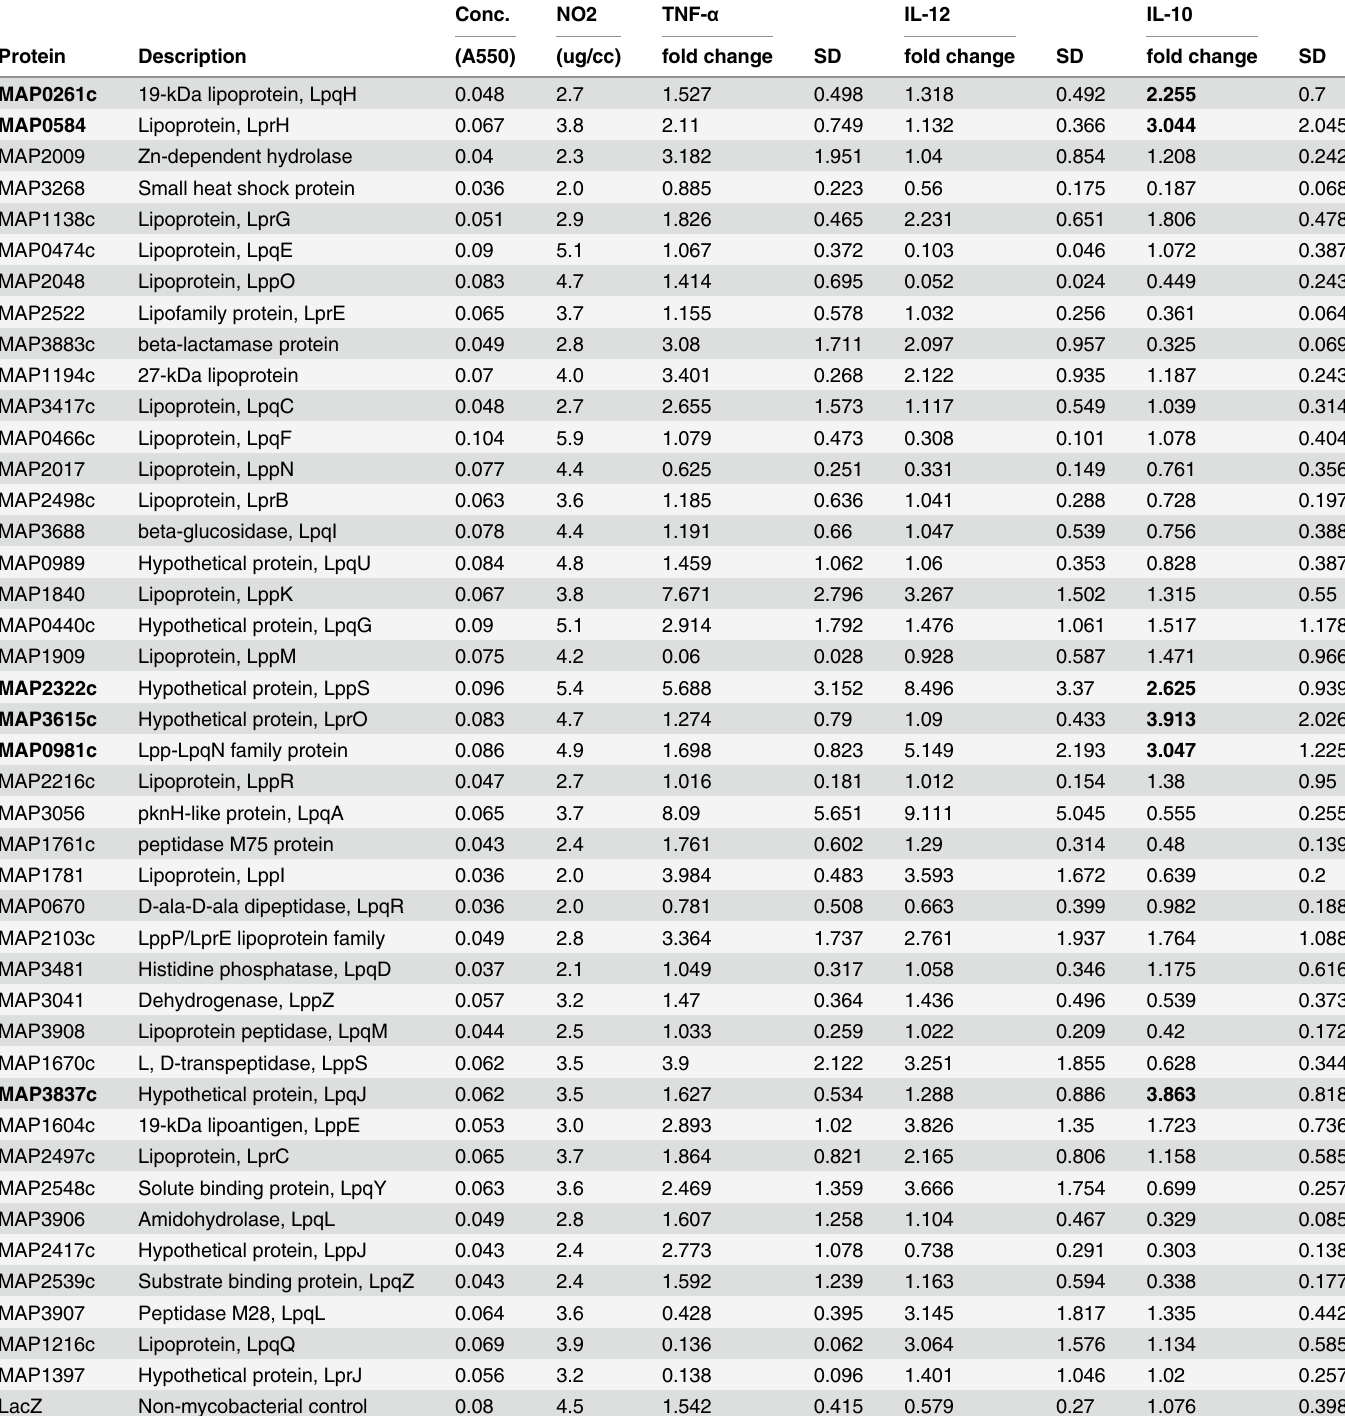
Table 2. Mycobacterium avium subspecies paratuberculosis protein effect on NO2 and cytokines.